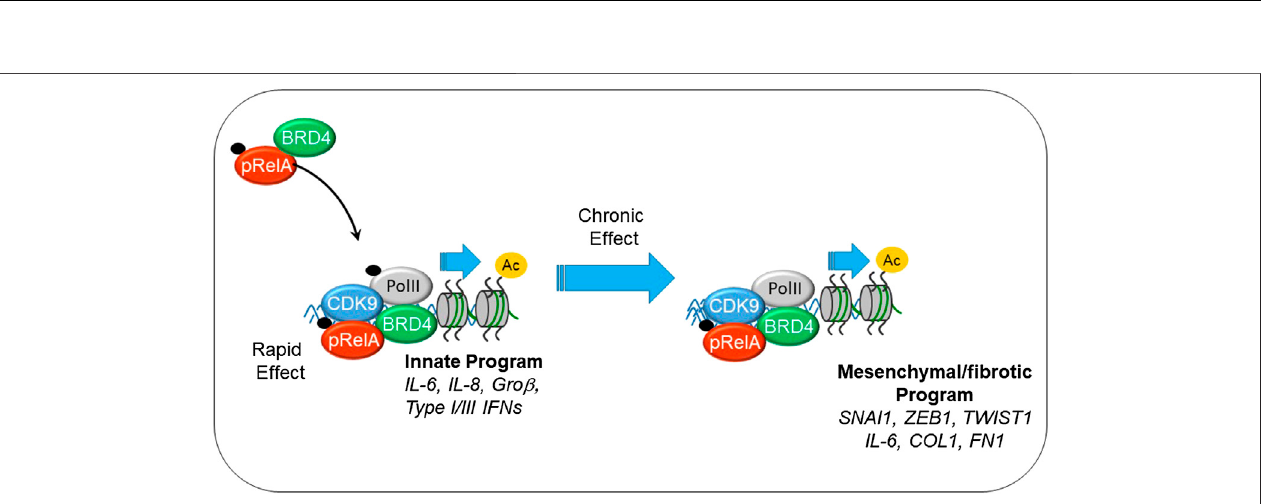
FIGURE 1 | Epithelial injury hypothesis in IPF. Shown is a schematic view of the relationship between injury of the epithelial surface, epithelial-mesenchymal transition and formation of fi brogenic foci.